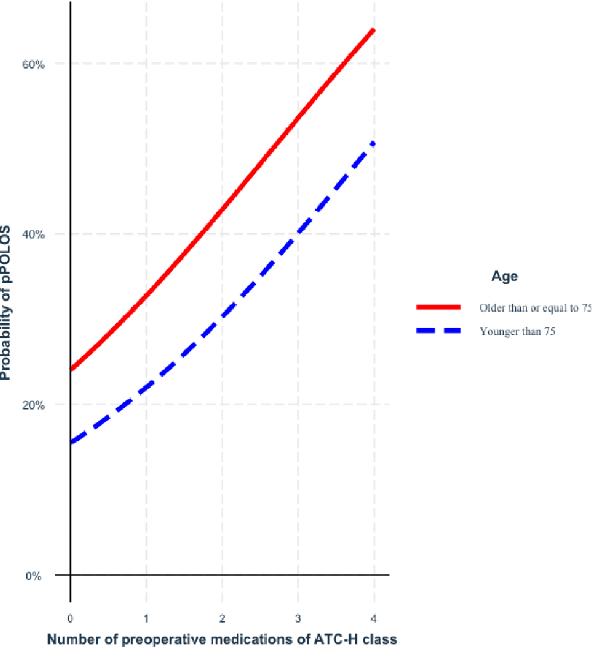
Figure 2. Probability of prolonged postoperative length of stay (pPOLOS) for each additional ATC- H drug, depending on patient’s age. ATC-H = ATC classification code H—systemic hormonal preparations, excluding sex hormones and insulins; pPPOLOS = prolonged postoperative length of stay.